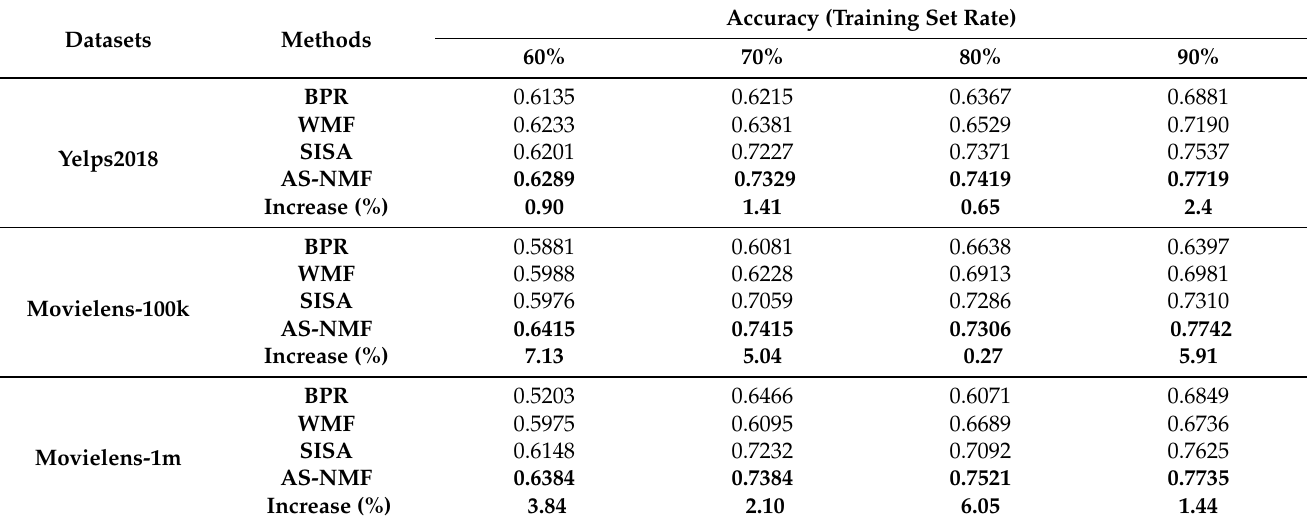
Table 2. Comparison of different methods for recommendation accuracy. The proposed AS-NMF method is tested with a different training set rate in this Table. The best results and improvement are highlighted in